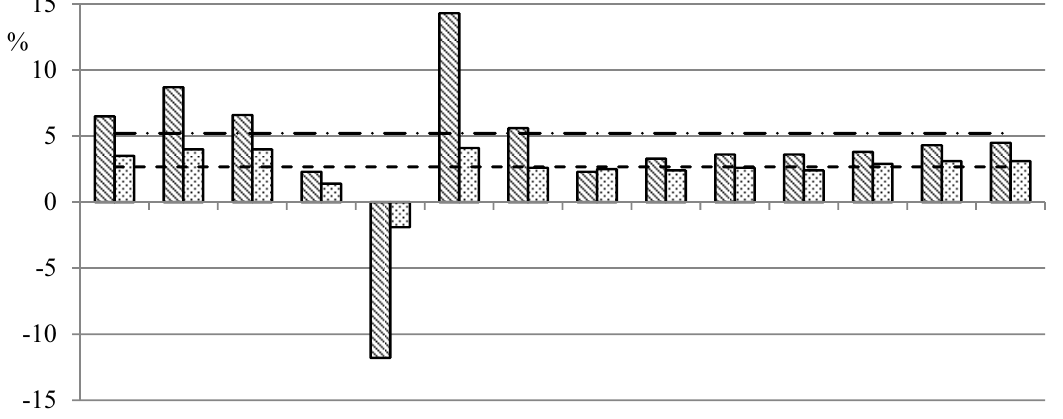
Fig. 1. Dynamics of world trade and GDP in 2005-2015